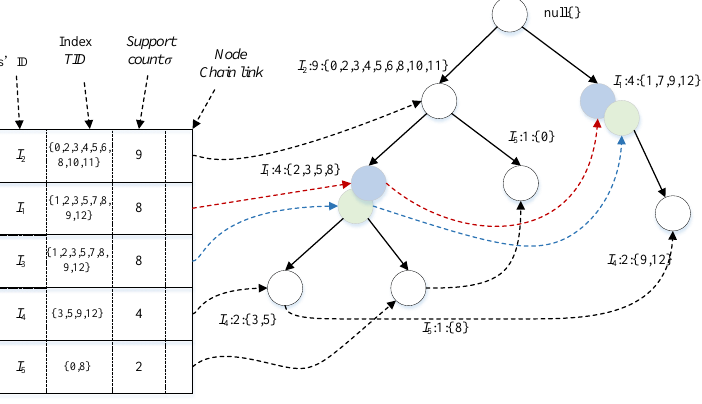
Figure 4. Pattern mining purpose.